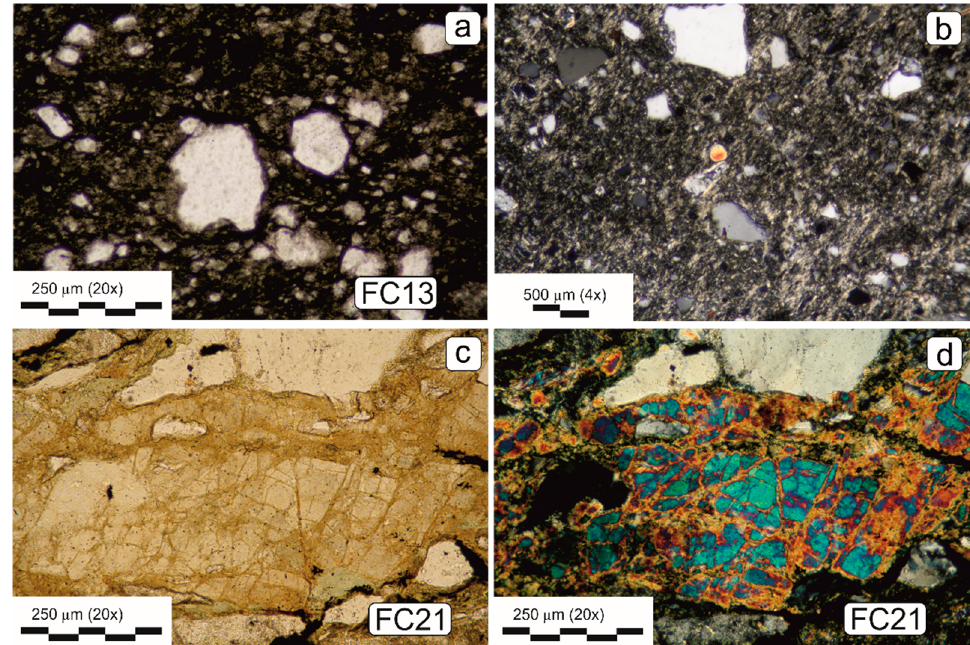
Figure 8. ( a ) Rounded quartz clasts in black tourmalinite of sample FC13. The rounded shape and the occurrence of embayments on larger clasts is a clue for chemical reaction between fluids and former cataclasite. ( b ) Microscopic aspect of a gray cataclasite (sample FC22); two crystals of tourmaline occur close to the center of the image. ( c ) Aggregate of light green, slightly pleochroic tourmaline crystals formed in a vein that branches out of the fault core into the footwall. The crystal aggregate has undergone weak cataclasis after its formation, as clearly visible in the cross-polarised image ( d ). At Forcellino Pass, black tourmalinites represent the strongest effect of tourmaliniza- tion; however, there are other, less tourmalinized facies, especially in the basement, in